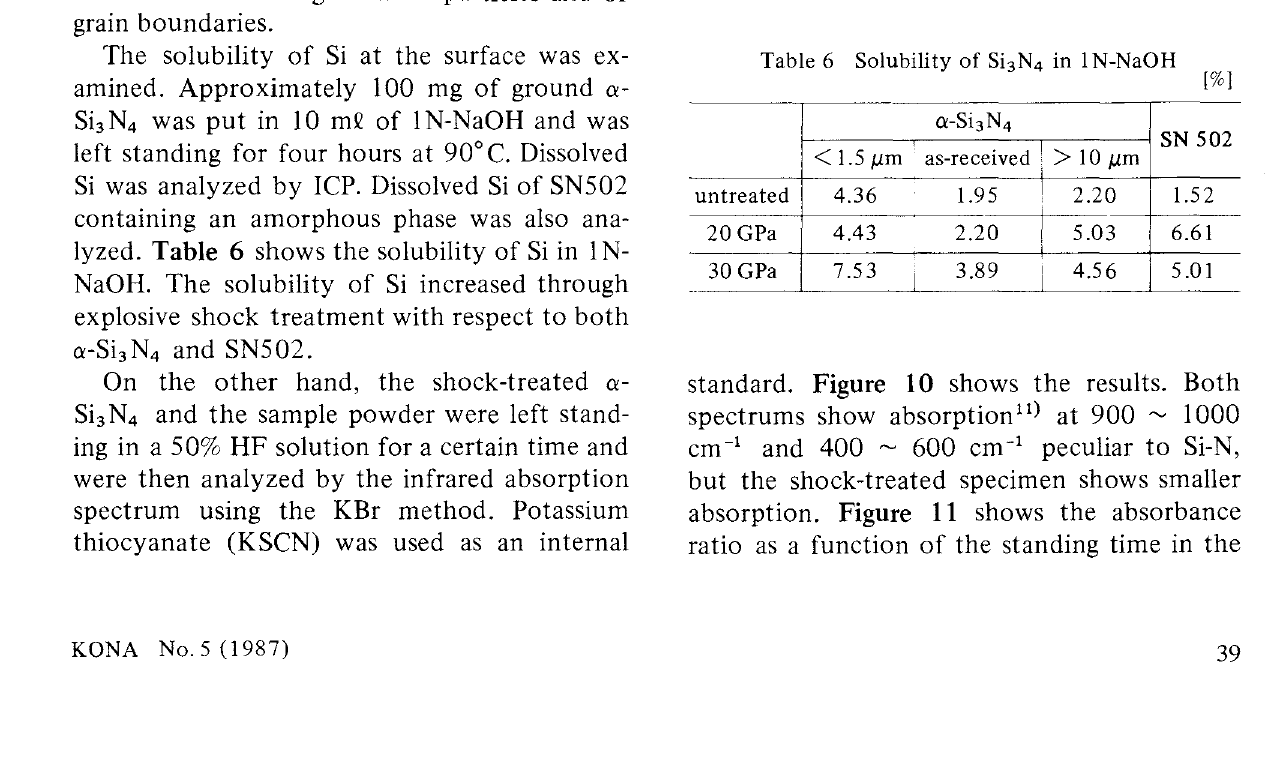
Fig. 9 SEM of explosively shocked Si3N4 (~-Si3N 4 , ca. 30 GPa)